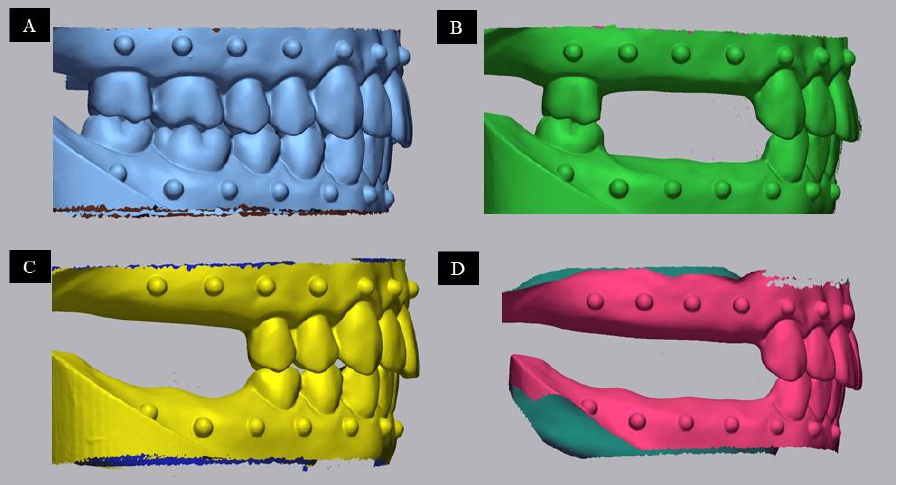
Figure 2. Experimental model. ( A ) FPS: Full Posterior Support, ( B ) PPS: Partial Posterior Support, ( C ) SSDEB: Short Span Distal Extension Base, ( D ) LSDEB: Long Span Distal Extension Base.